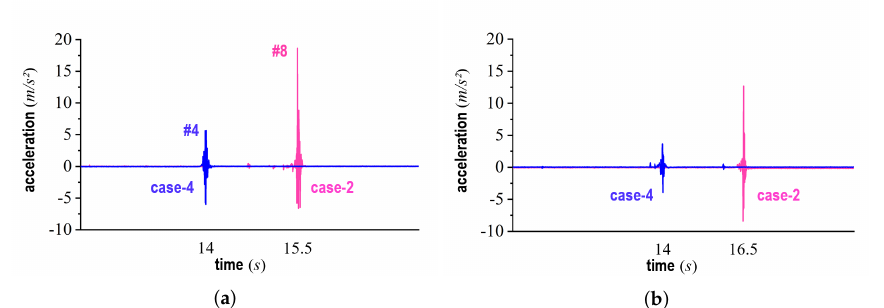
Figure 21. Comparison results for accelerations triggered when climbing steps where case − 2 and case − 4 denote the wheel with a vertically translated axle and the proposed wheel, respectively. More- over, the frame numbers under the case of 20 mm mean a specific motion scene in Figures 16 and 17a, respectively. ( a ) Step height of 20 mm, ( b ) step height of 30 mm.